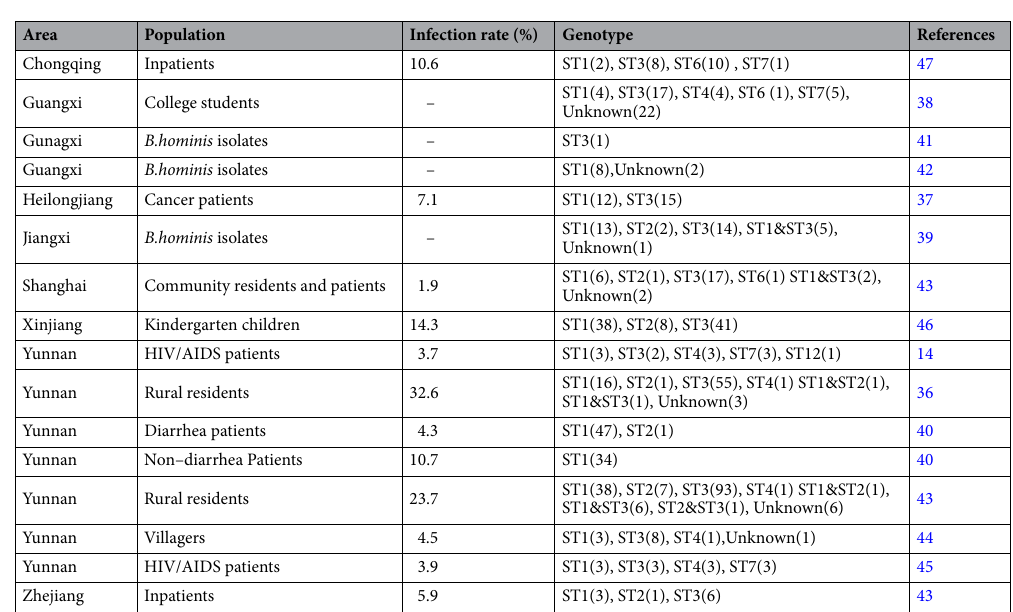
Table 3. Genotype distribution of B. hominis in different population groups on the basis of geographical locations in China.